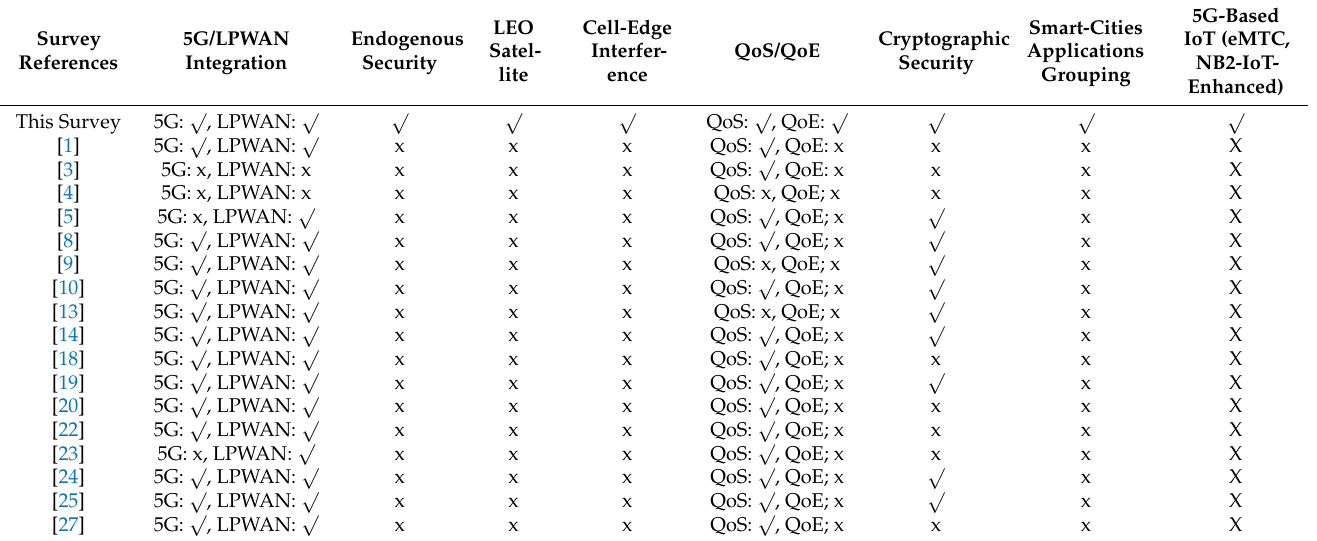
Table 1. Comparisons of existing LPWAN-IoT Surveys with regards to consideration of the high- √ lighted factors (Considered: , Not considered: